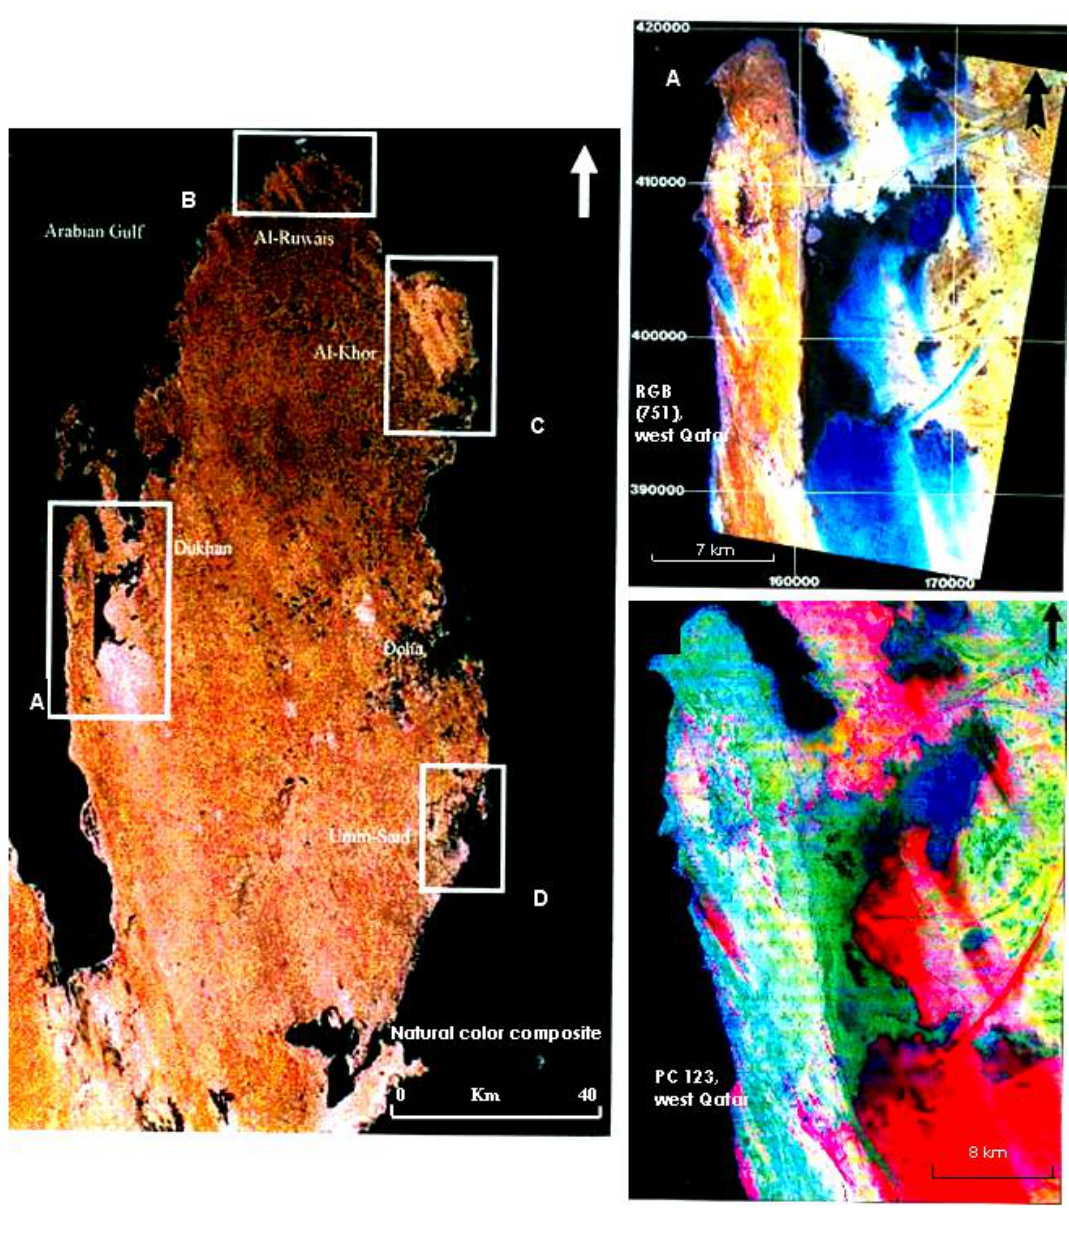
Figure 2. Natural color image of Qatar as well as RGB and PC images of the western part of the study